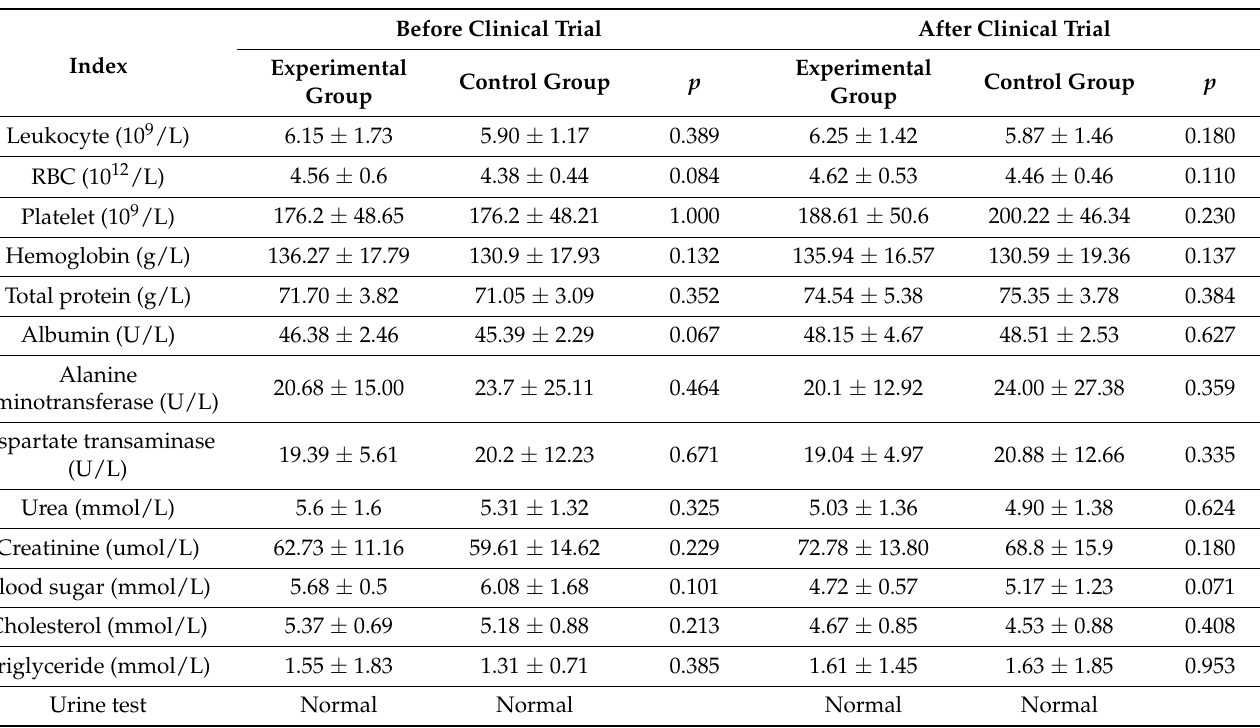
Table 3. The effect of Magtein ® PS on levels of human blood and urine biochemical